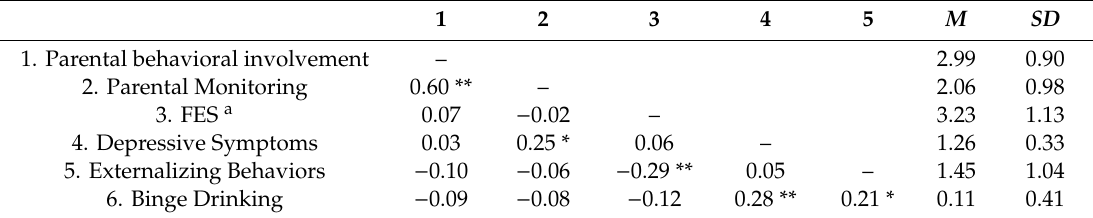
Table 1. Bivariate correlations and descriptive statistics for study variables.